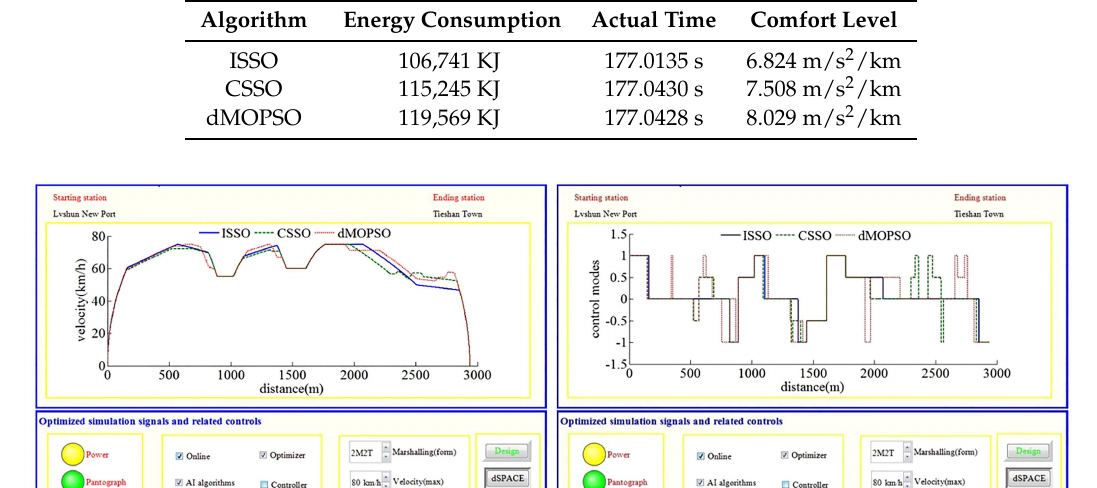
Table 9. The HILS optimization results of different algorithms for Jinpu line No.1 in Dalian scenario.